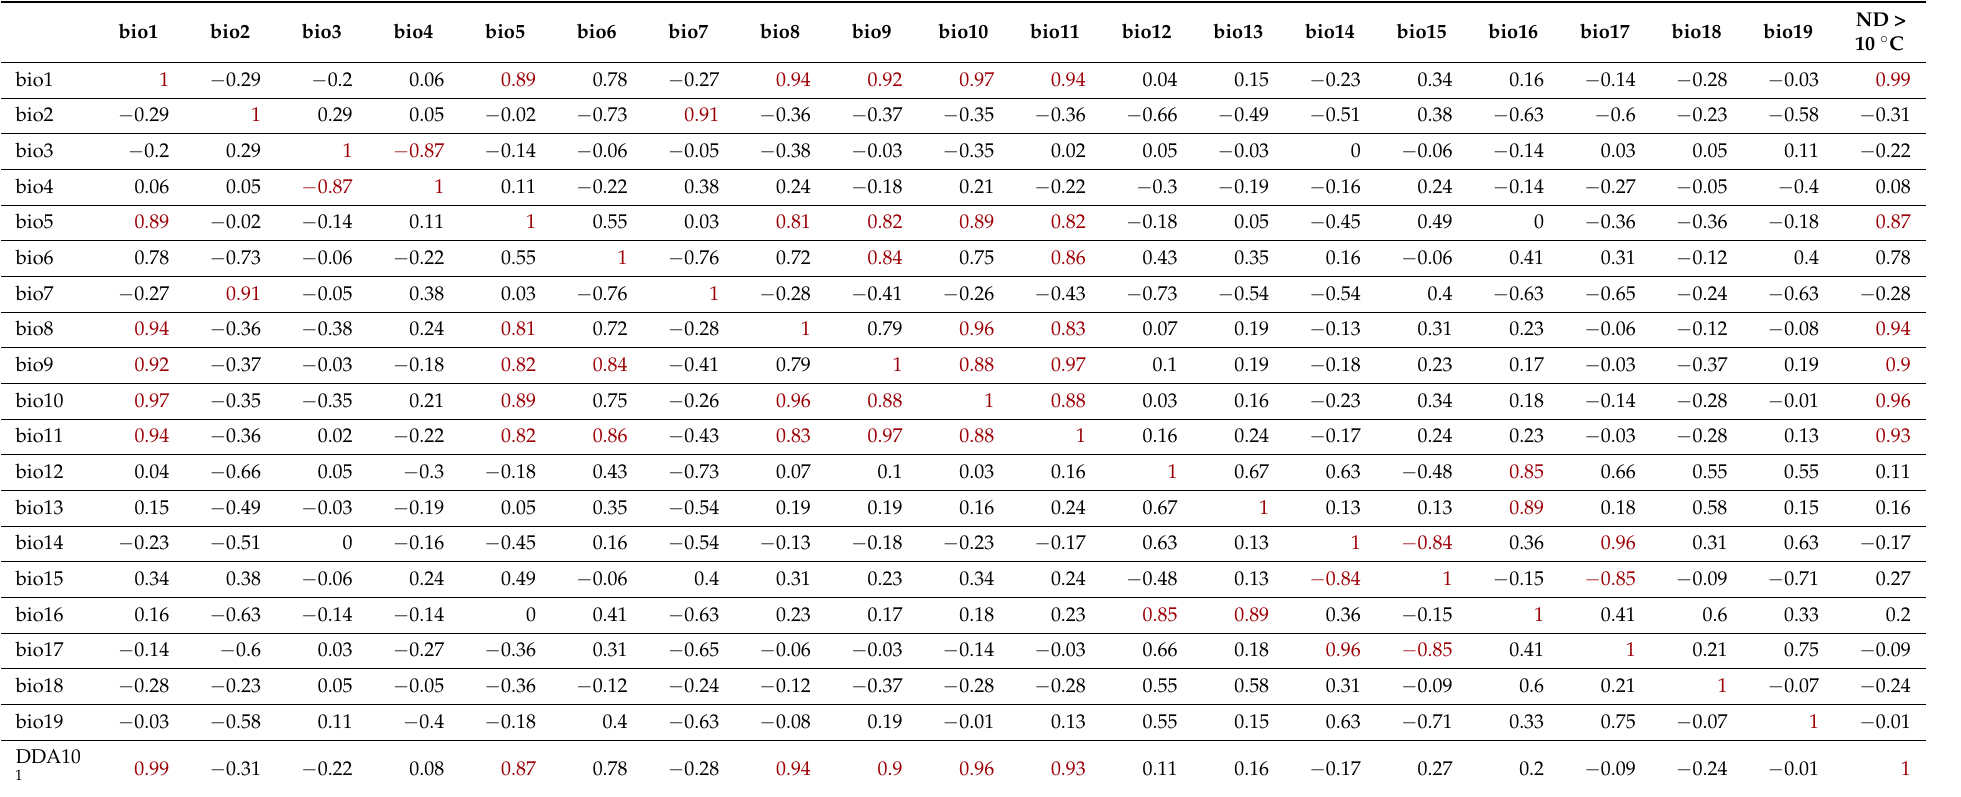
Table A1. Spearman rank-order of removing correlations in a variable with higher pairwise correlation coefficients (|r| > 0.8) with red color highlight. DDA10 is Degree days above 10 ◦